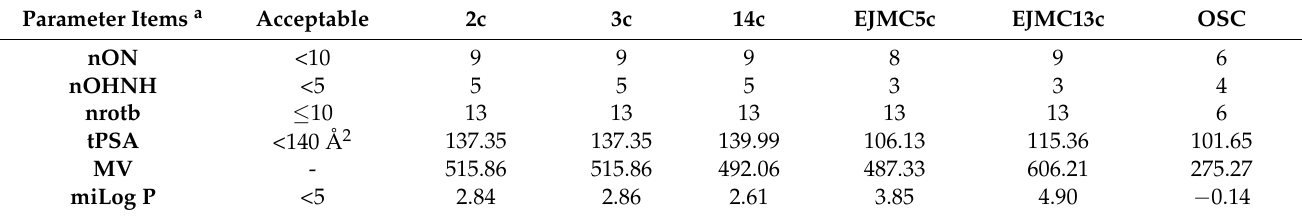
Table 5. Physicochemical properties of some selected compounds and OSC